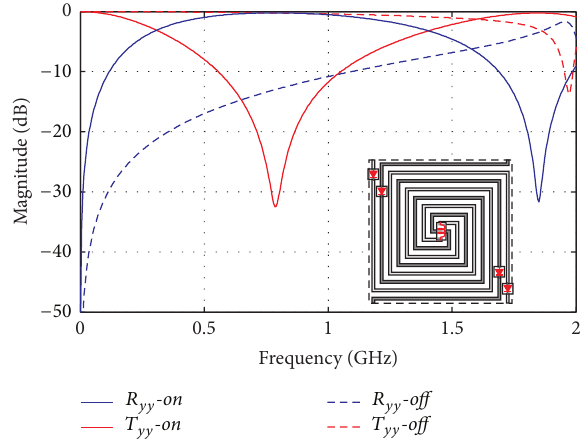
Figure 6: Transmittance and reflectance of the AFSS with the unit cell of Figure 1 at normal incidence of a y -polarized wave when the four pin diode switches in the spiral arms are in the on (solid lines) and off (dashed lines) states. The on and off states of pin diodes are modelled with their equivalent circuits of Figure